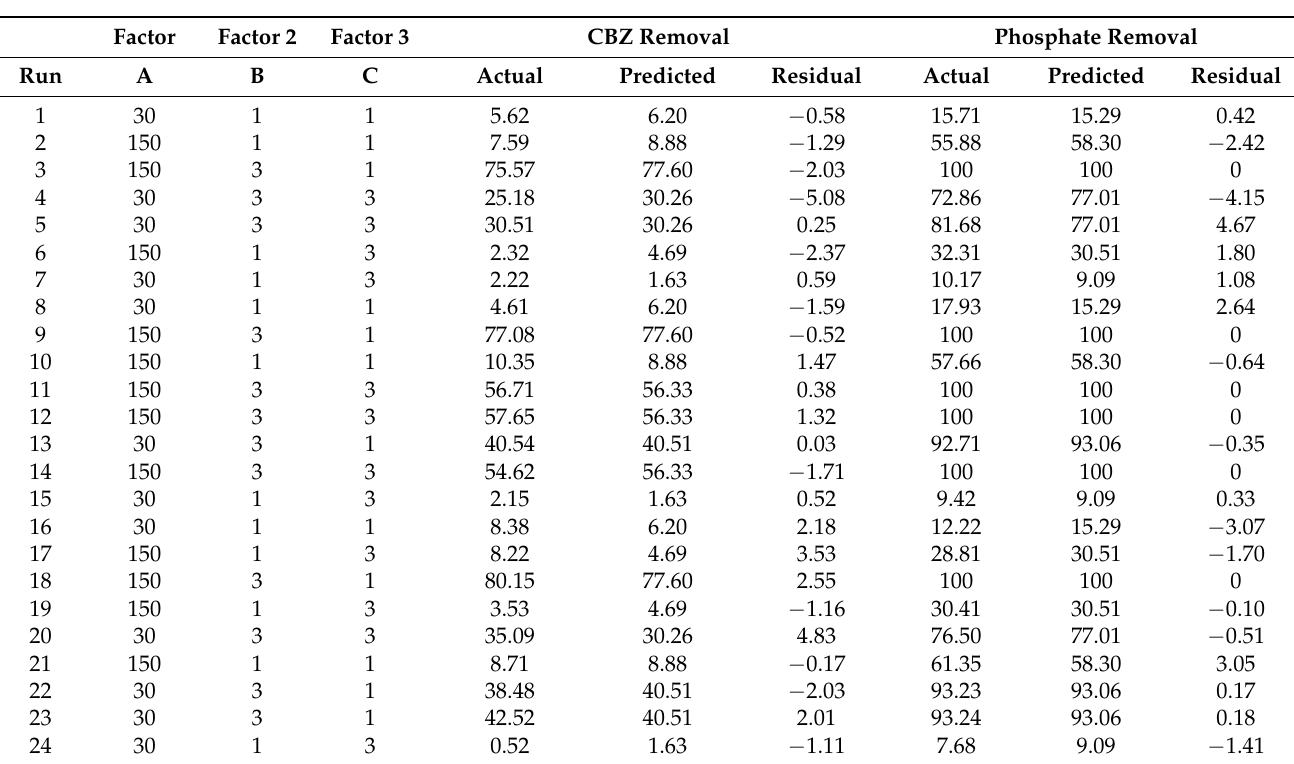
Table 3. Factorial design matrix of three variables along with experimental and predicted responses for CBZ and phosphate removal.